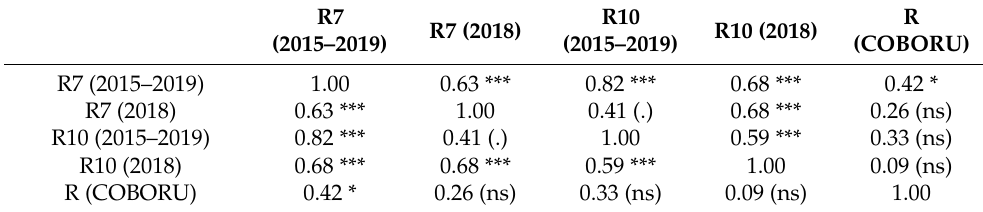
Table 4. Spearman’s rank correlation coefficients between cultivar rankings for environments pro- ductivity 7 (R7...) and 10 t/ha (R10...), based on the data used in this study (2015–2019), data from 2018 [11] and the COBORU recommendation